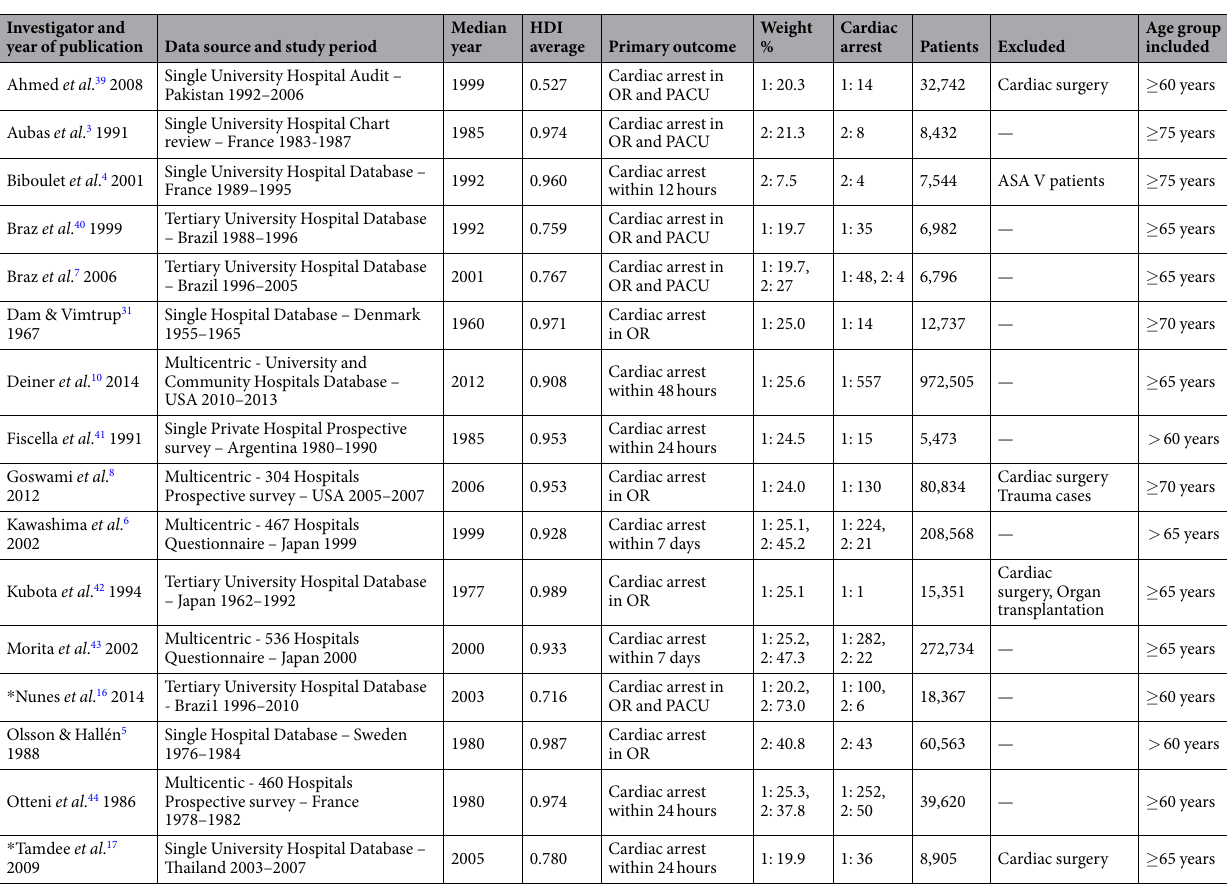
Table 1. Characteristics of included studies with references. Abbreviations . HDI: Human Development Index, the score ranges from 0 to 1, which represents the lowest and highest levels of development, respectively; OR: operating room; PACU: postanesthesia care unit; Weight (%): study weight contribution to the pooled analysis of the proportion effect size; 1: perioperative cardiac arrest; 2: anesthesia-related cardiac arrest; * Studies that included only geriatric